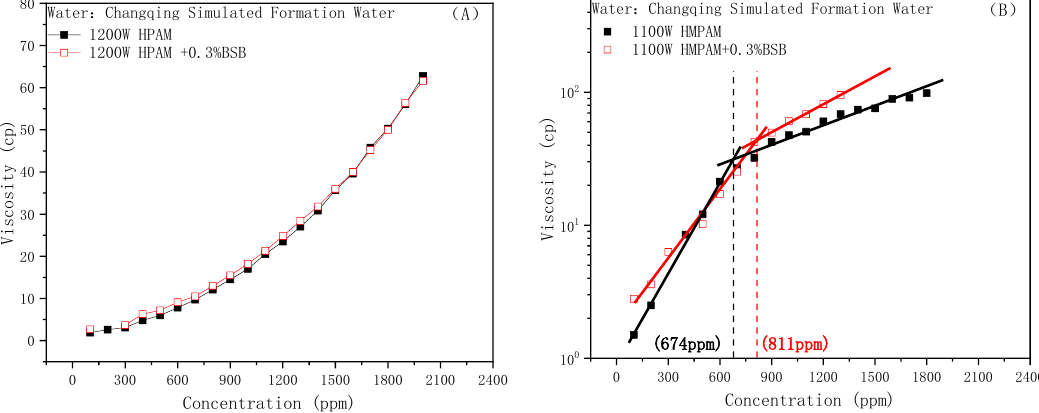
Figure 5. Effect of BSB on the polymer viscosity: ( A ) HPAM, ( B ) HMPAM.